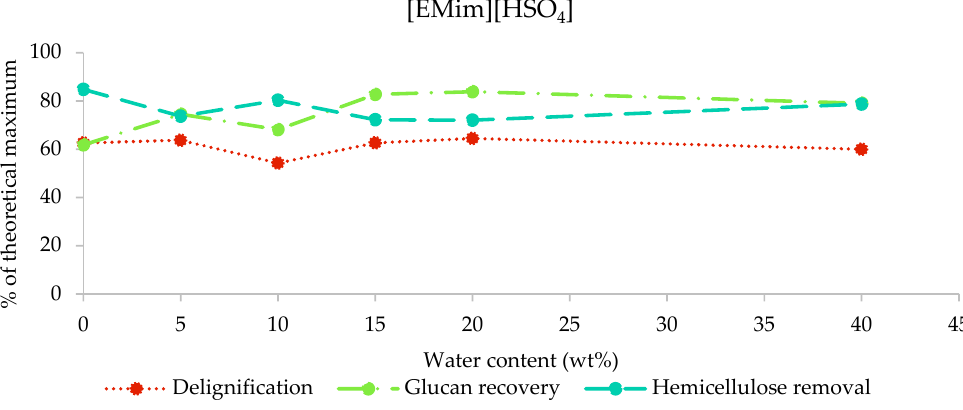
Figure 5. Delignification, glucan recovery, and hemicellulose removal after the pretreatment of poplar with [EMim][HSO 4 ] containing 0–40 wt% water for 46 h at 100 °C.